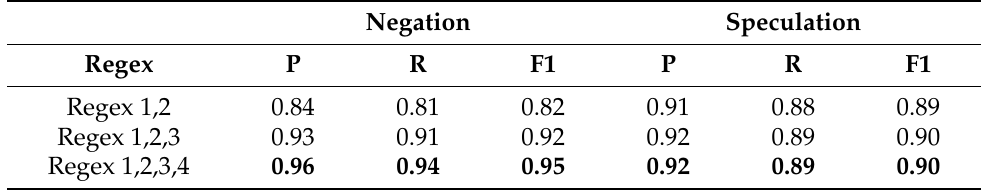
Table 4. Results for the cue detection